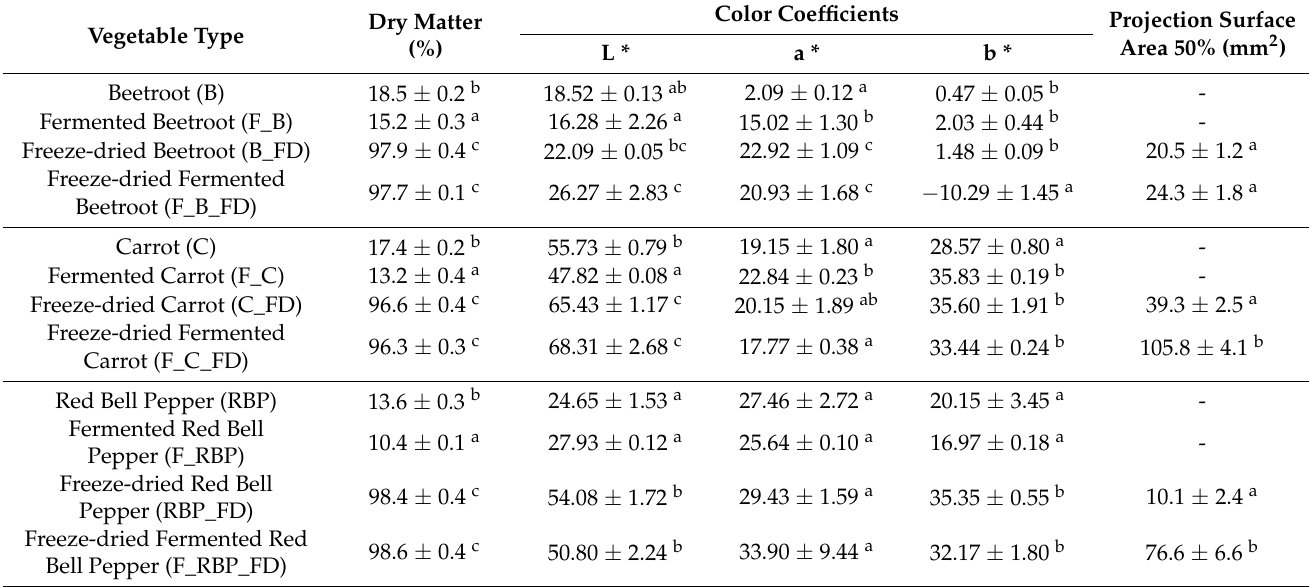
Table 2. Selected physical properties of raw and freeze-dried vegetables.